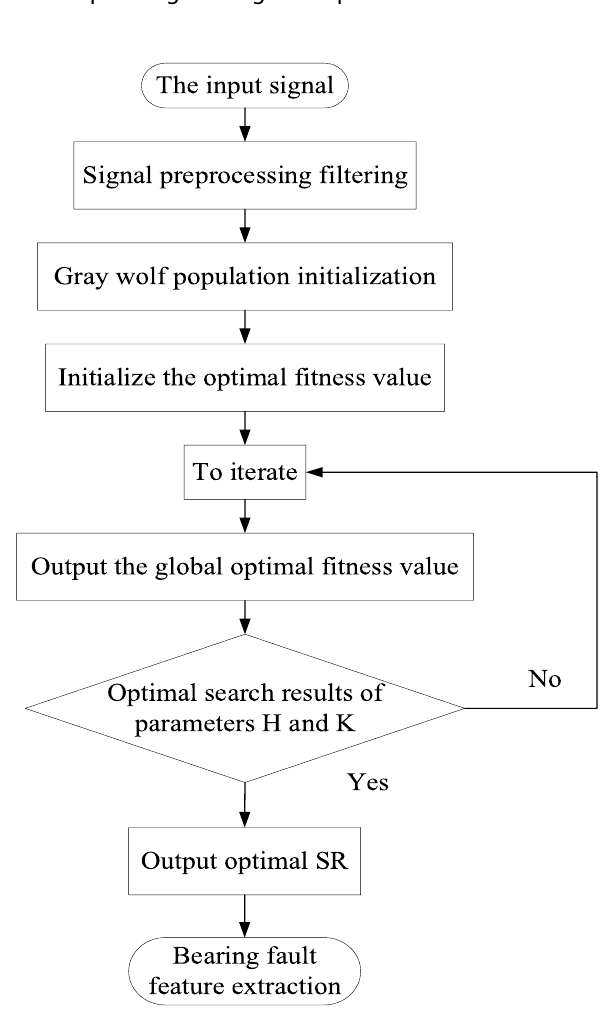
Fig. 3 Influence of GWO on output SNR after optimization of parameters H and K Fig. 4 Flowchart of GMO-SR